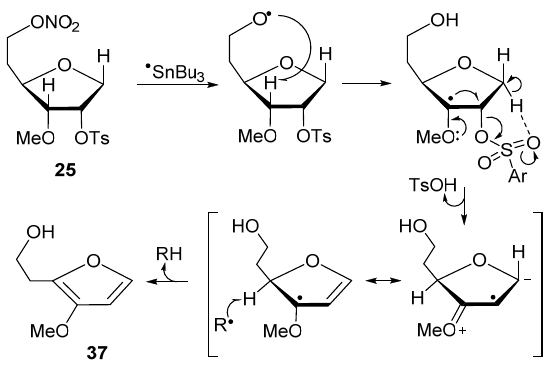
Figure 5. TsOH elimination and aromatization.